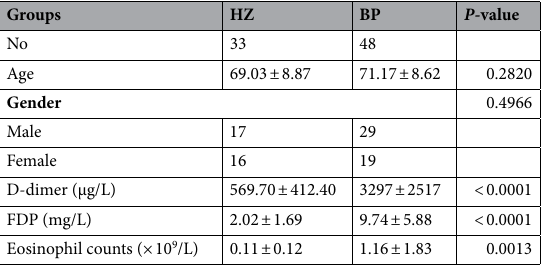
Table 2. Demographic characters of patients with HZ and